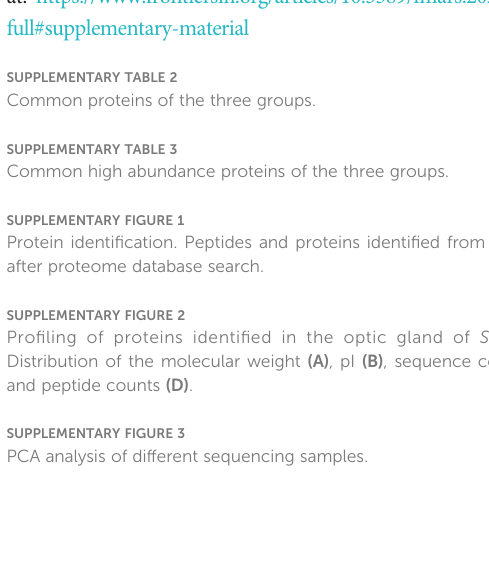
SUPPLEMENTARY FIGURE 3 PCA analysis of different sequencing